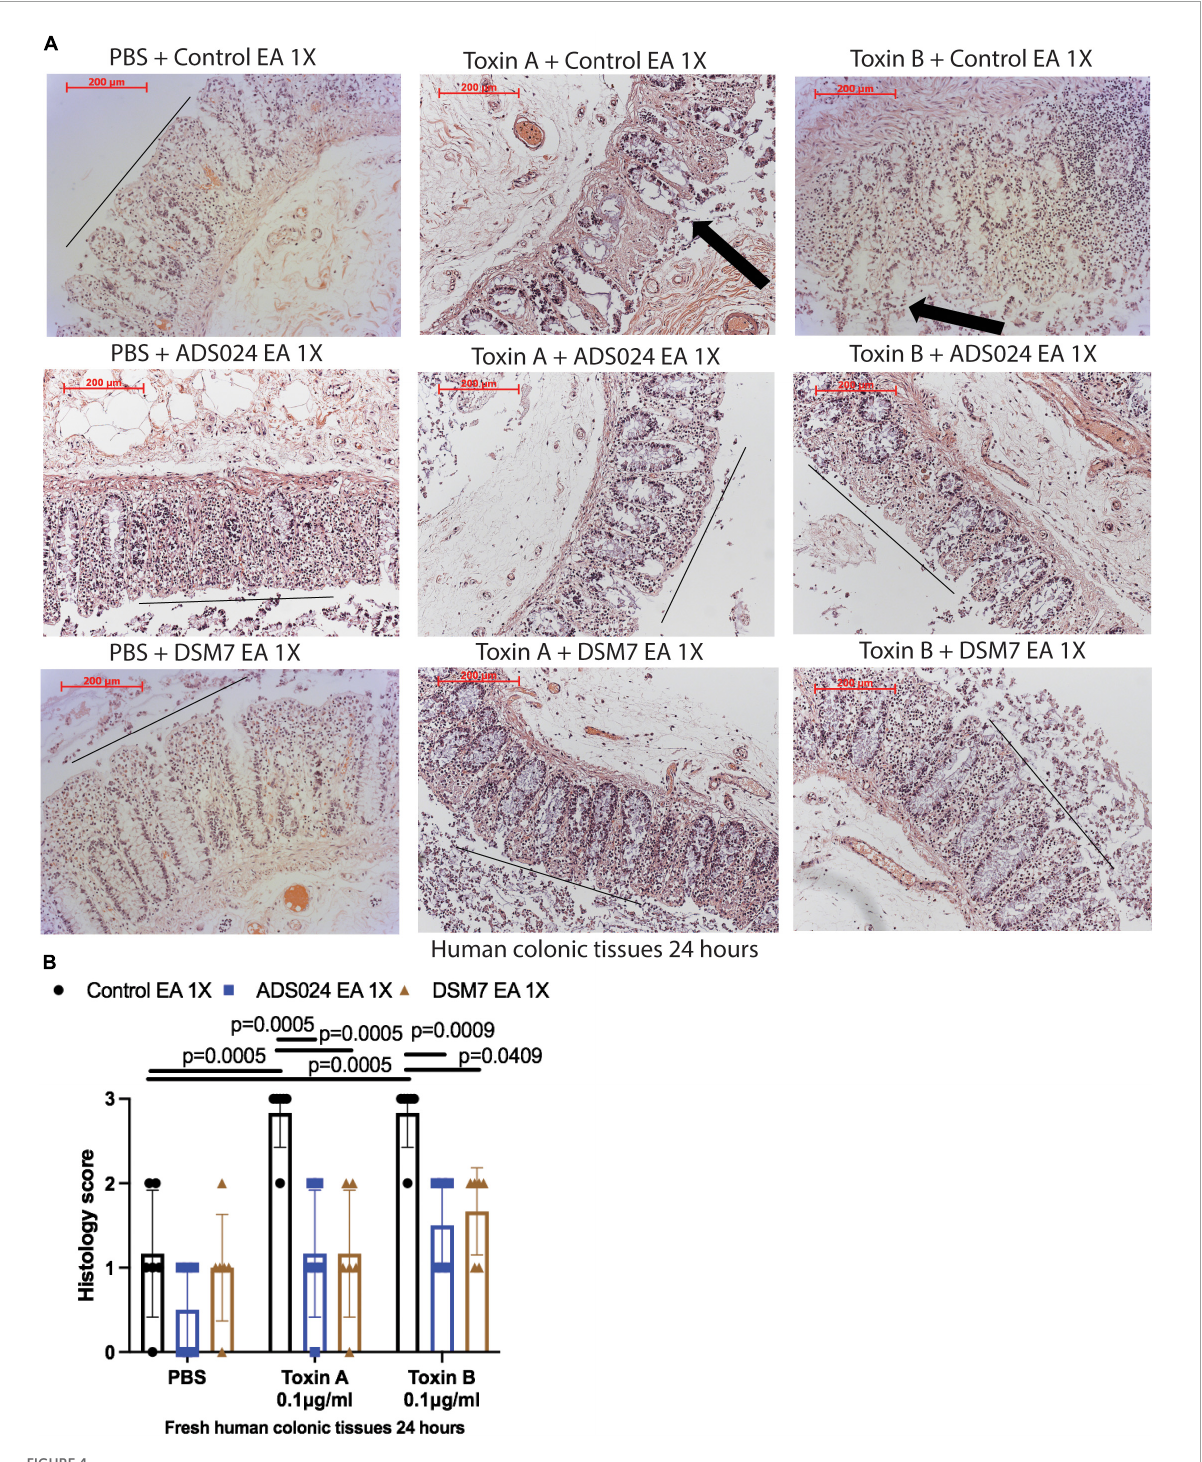
FIGURE4 ADS024 ethyl acetate extract reduced toxin-mediated epithelial injury in fresh human colonic explants. Fresh human colonic explants were placed in serum-free RPMI1640 media with PBS or 0.1% v/v of ADS024 and DSM7 EA extracts at 1X. Thirty minutes later, toxin A and toxin B (0.1 µ g/ml) were added and further incubated for 24 h. (A) H&E-stained images at 100X magnification. Black lines indicated the integrity of the top lining of colonic mucosa in PBS control groups and toxin- and EA extract-treated groups. Arrows indicated toxin-mediated disruption of mucosal integrity and thickness. (B) Histology scores for epithelial injury (0–3). EA extracts of ADS024 and DSM7 reduced toxin-mediated epithelial injury. Results were pooled from samples from 10 patients. One-way ANOVA tests were